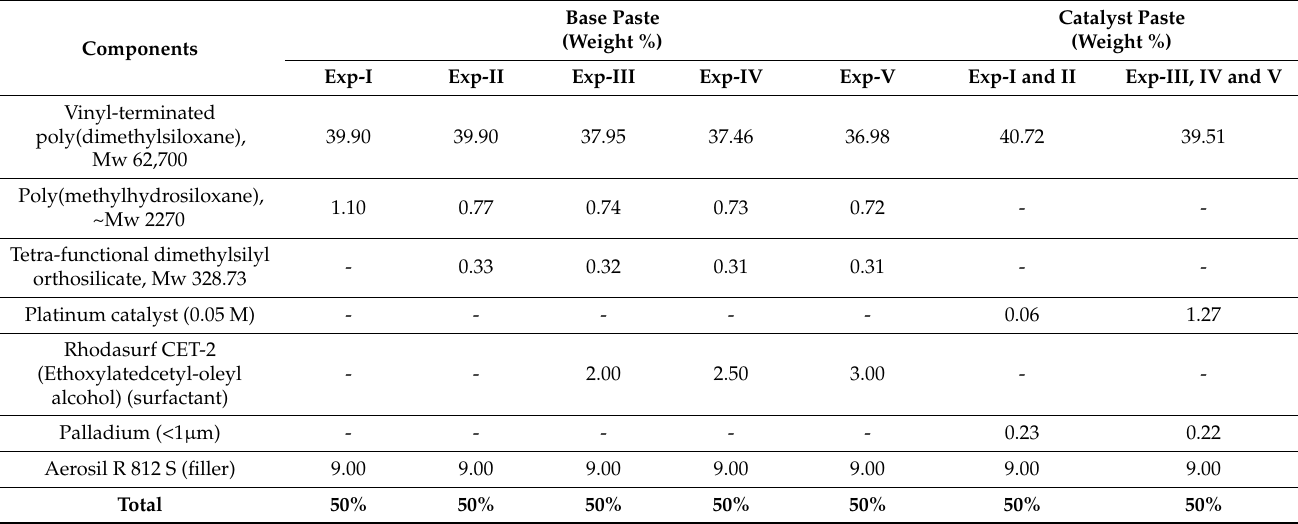
Table 2. Formulations of novel Exp (I, II, III, IV, V) VPS impression